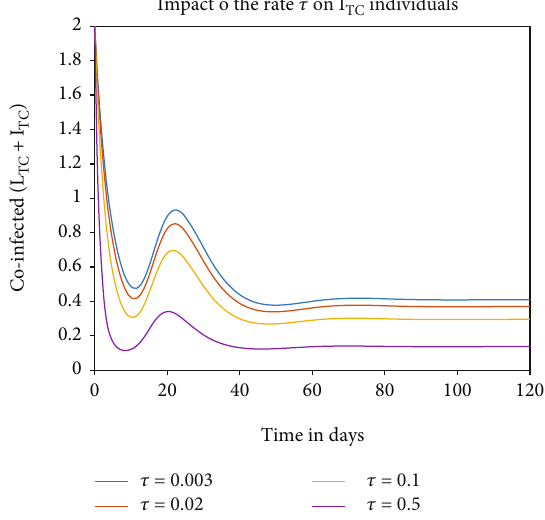
τ given in the TC with the values of